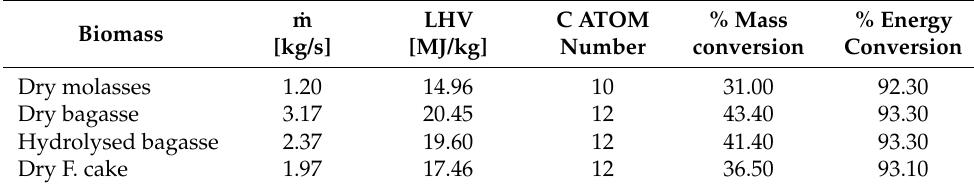
Table 7. Stoichiometric carbon capturing efficiency in biomass to hydrocarbon